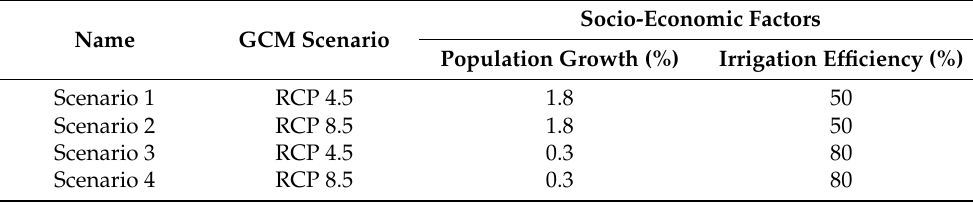
Table 3. Characteristics of the scenarios considered for this study.